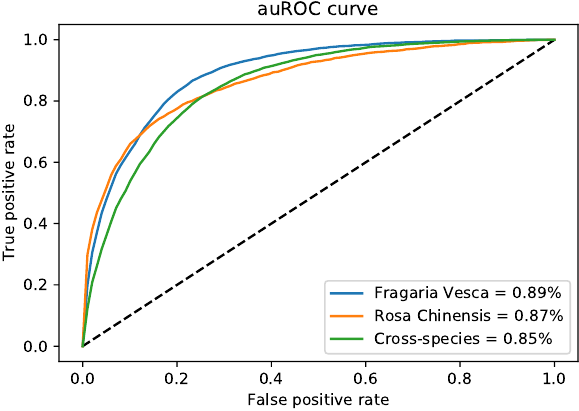
Figure 10. auRoc curves of three independent benchmark dataset on DNC4mC-Deep